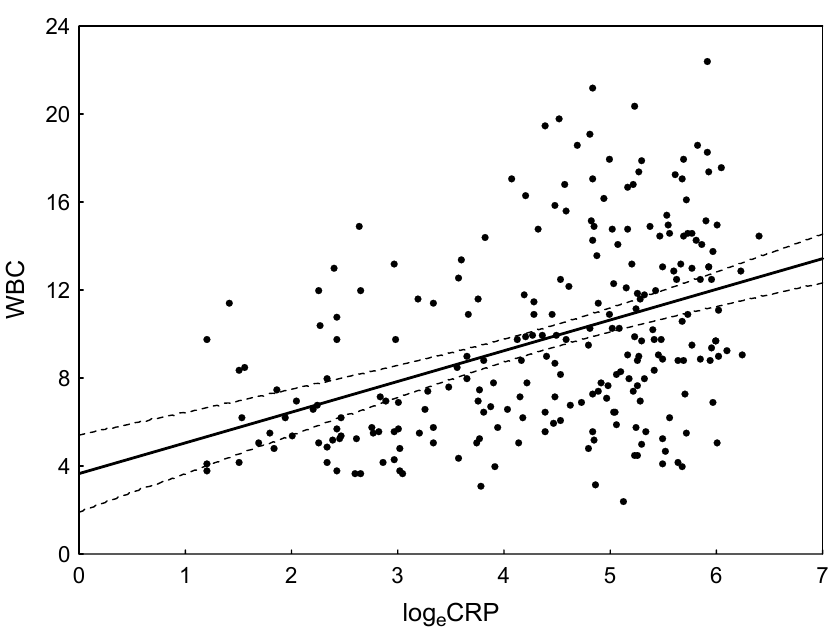
Fig. 1 Regression line for the relationship between WBC count and CRP plasma con- centration (log e -transformed) in AP patients (data from the 5-day observation period). The regression equation: WBC ( × 10 3 / μ l) = 3.66 + 1.40 × log e CRP (mg/l).